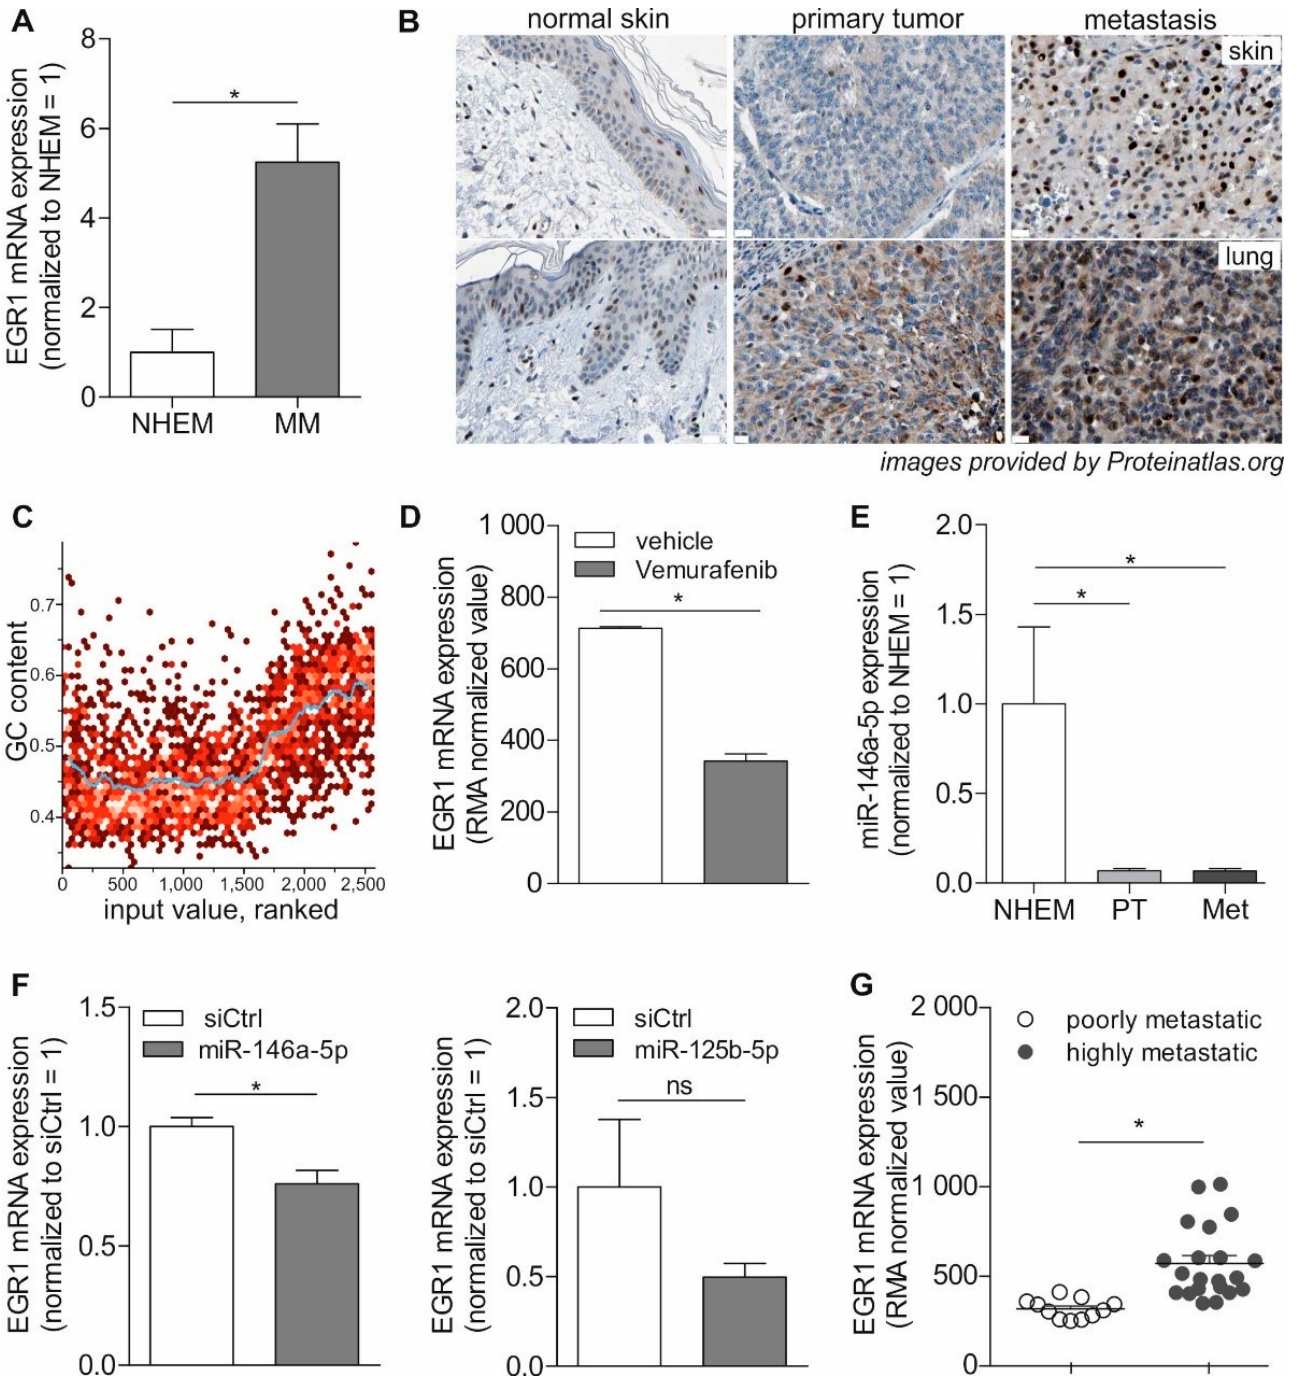
Figure 5. EGR1 expression and regulation in melanoma in 2D culture or tissue sections. ( A ) qRT-PCR analysis shows significantly increased EGR1 mRNA expression in seven malignant melanoma cell lines (MM; n = 14) compared to primary melanocytes (NHEM; n = 3). ( B ) EGR1 immunohistological staining of skin or melanoma tissue (publicly available data from Proteinatlas.org [54,55]) shows increasing staining intensity and nuclear staining from normal melanocytes in the basal layer of the epidermis (Patient-ID: 2156; 3403) over primary tumor (PT; Patient-ID: 3611; 2900) to metastasis (Met, Patient-ID: 1020 (skin); 2317 (lung)) [56,57]. ( C ) STRING analysis of the ranked values of differential gene expression (2D vs. 3D alginate) revealed a correlation with GC-content of associated genes (Pearson’s r-value: 0.547, Pearson’s p -value: 10 -32 , BP-R 2 : 0.399 (very high)). ( D ) Affymetrix array data showing a decrease in EGR1 mRNA expression in the melanoma cell line A375 treated with the BRAF inhibitor vemurafenib ( n = 3) compared to A375 treated with vehicle (0.1% DMSO; n = 3) (Gene Expression Omnibus (GEO) Profiles: GDS5085/8108370, GSE42872, [40,58]) (RMA: Robust Multichip Average). ( E ) qRT-PCR analysis of EGR1 regulating miR146a expression is significantly decreased in melanoma cell lines from the